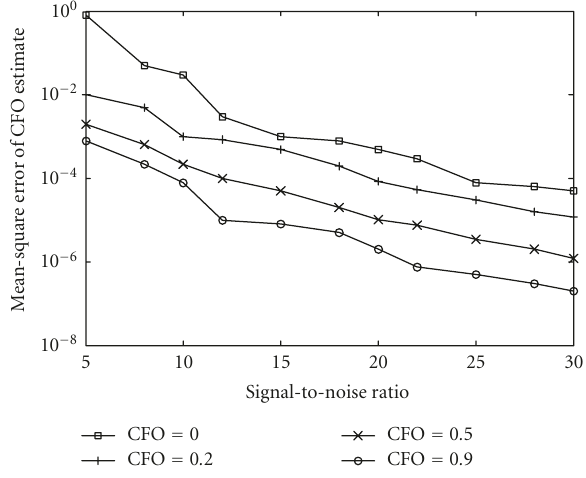
Figure 3: MSE of CFO estimate ( g = 1dB and θ = 15 ◦ ).